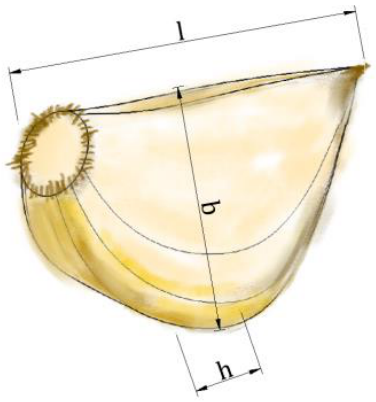
Figure. 2 Diagram of the triaxial size of garlic. Figure 2. Diagram of the triaxial size of garlic. Figure 2. Diagram of the triaxial size of garlic.